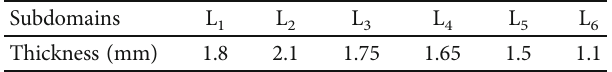
Table 7: Thickness distribution of the TRB concept tube without transition